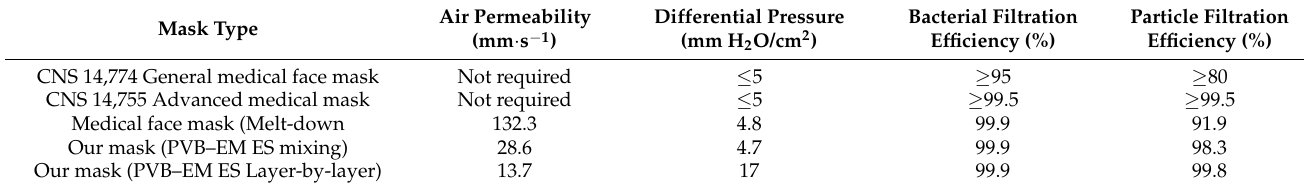
Table 2. Comparison of mask fabricated of PVB–eucalyptus microcapsule via mixing and layer-by- layer performances with current medical mask